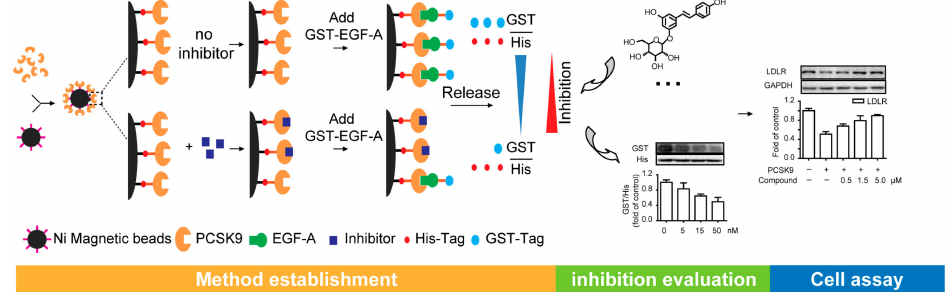
Figure 1. Strategy for evaluating the inhibition of natural products on the proprotein convertase subtilisin/kexin type 9 (PCSK9)/low-density lipoprotein receptor (LDLR) interaction. PCSK9